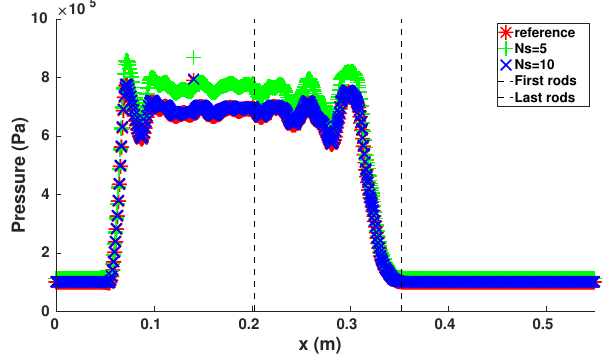
(cid:2) (cid:3) 10 − 4 , 10 − 3 - t = 1.6 × 10 − 4 s.